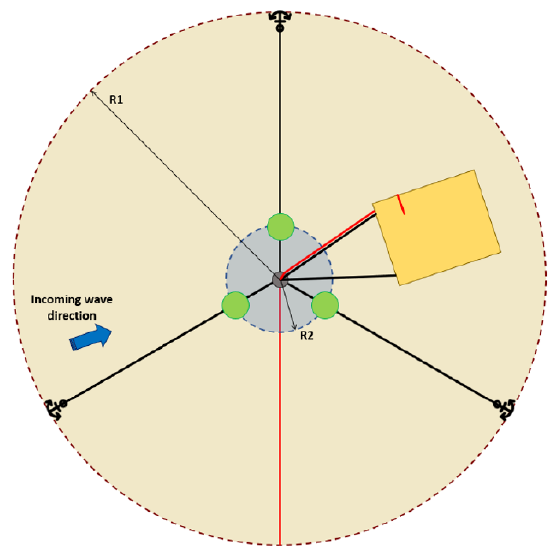
Figure 4. ISWEC mooring layout C2, top